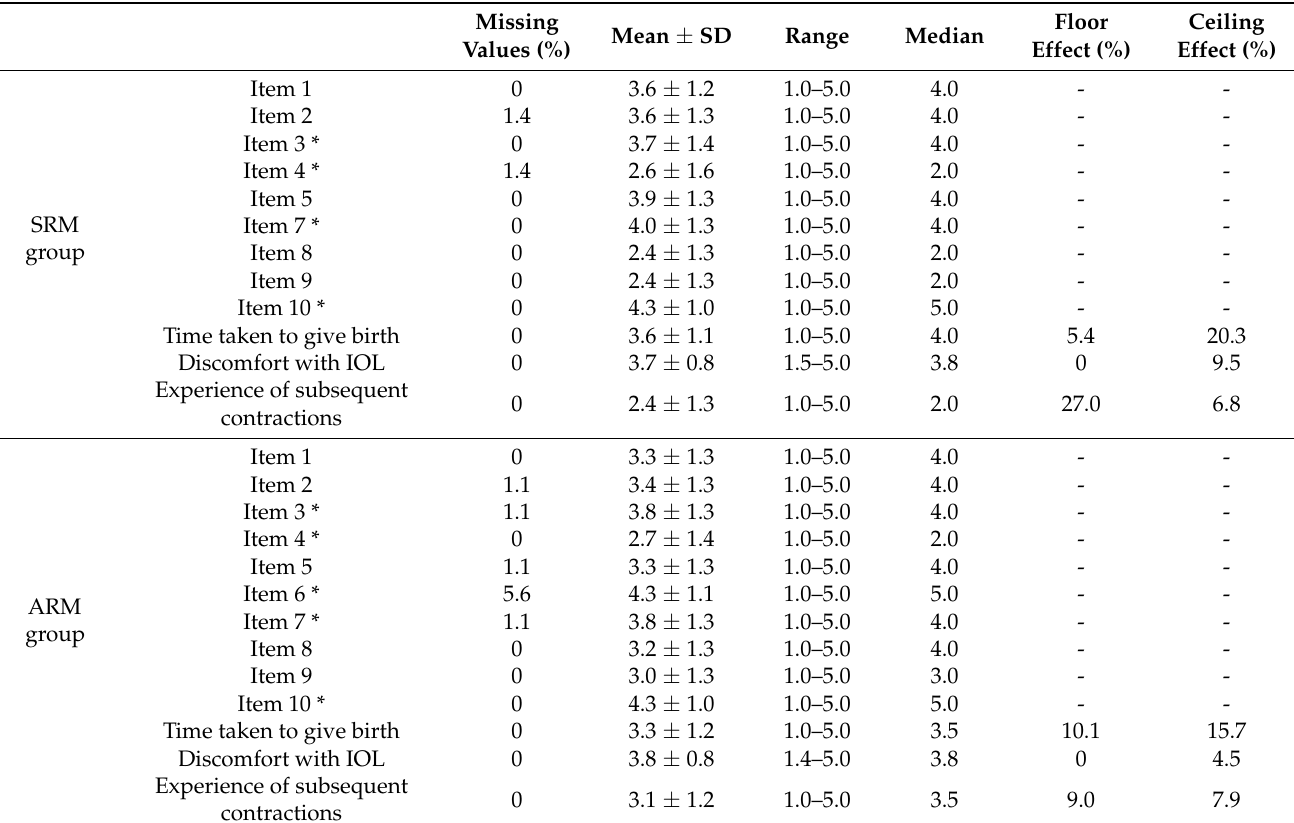
Table 3. Descriptive statistics and score distributions of the EXIT-French items and